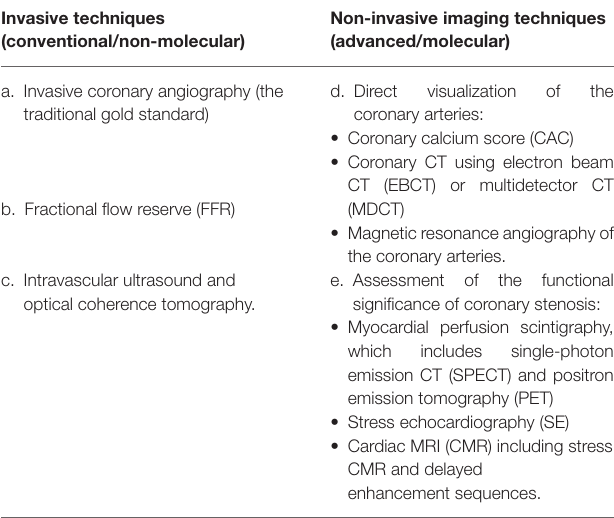
TABLE 1 | Various imaging modalities available for the investigation of suspected CAD. Invasive techniques (conventional/non-molecular)